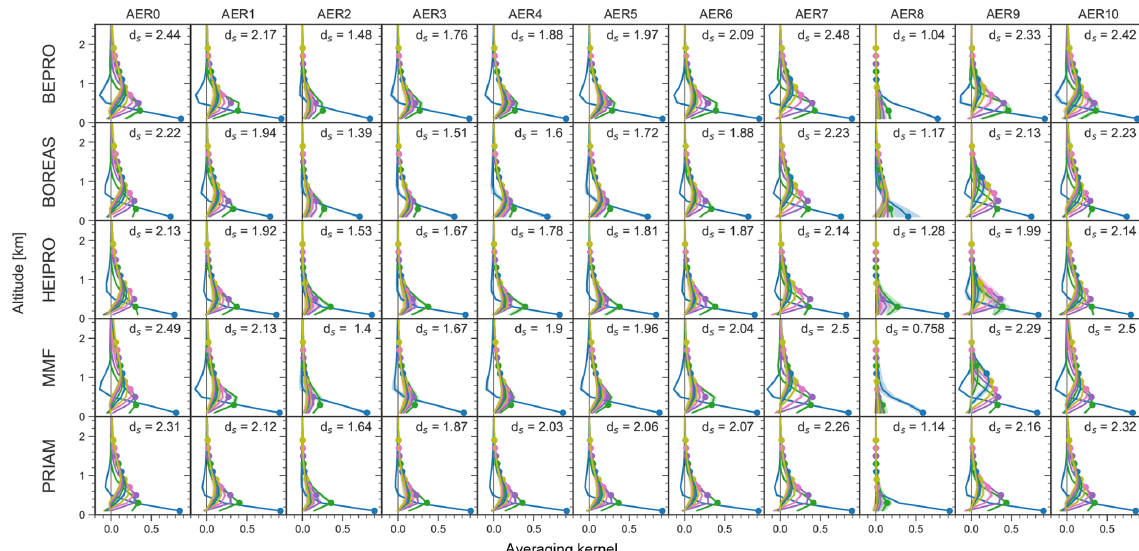
Figure 7. Same as Fig. 5, but for